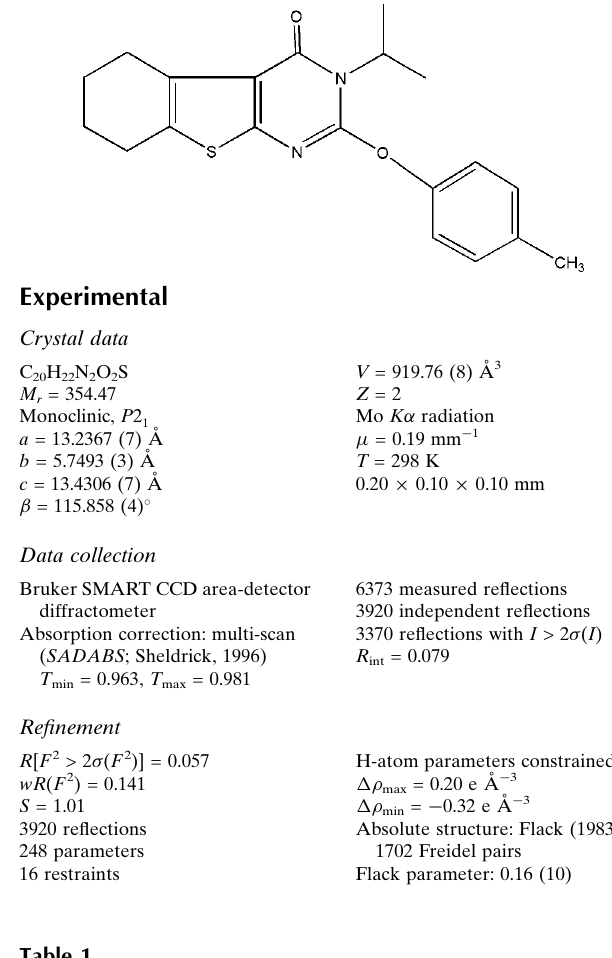
Hydrogen-bond geometry (A˚ , (cid:2)